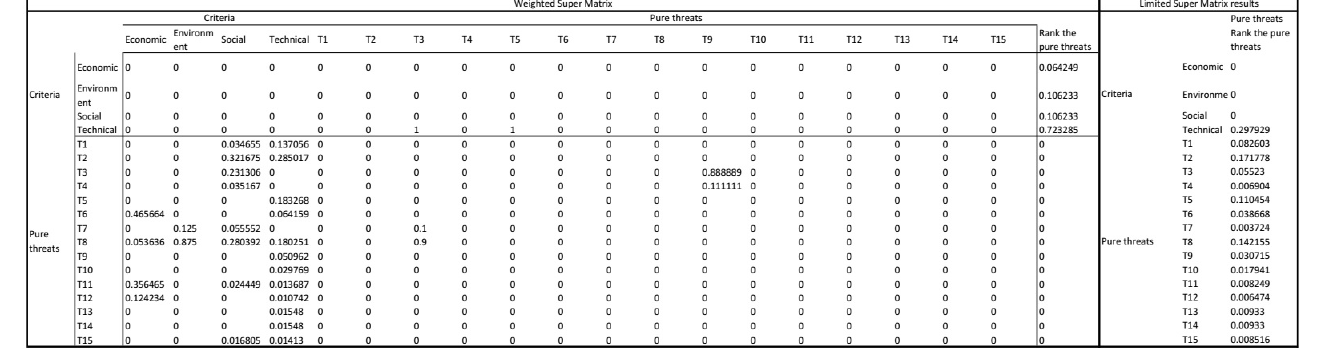
Figure 4. Threats unweighted supermatrix (exported from Super Decisions V3.2—the figure illus- trates the output of the software, which consists of the limiting super-matrix results and the weighted super-matrix. The weighted super-matrix contains the square matrix of pure threats T1 to T15 along with Criteria).